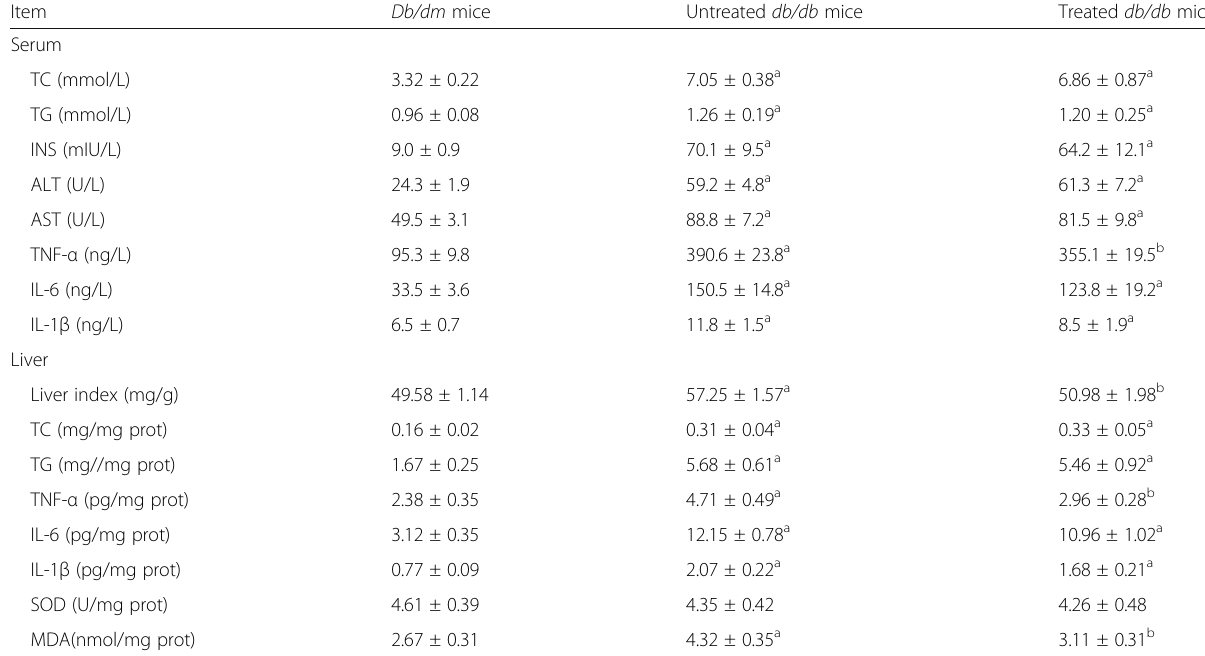
The results are expressed as mean±SEM ( n =8 per group). Values having different superscripts are significantly different, P <0.05, one-way ANOVA test. a Statistical difference compared to the db/dm mice, b Compared to the untreated db/db